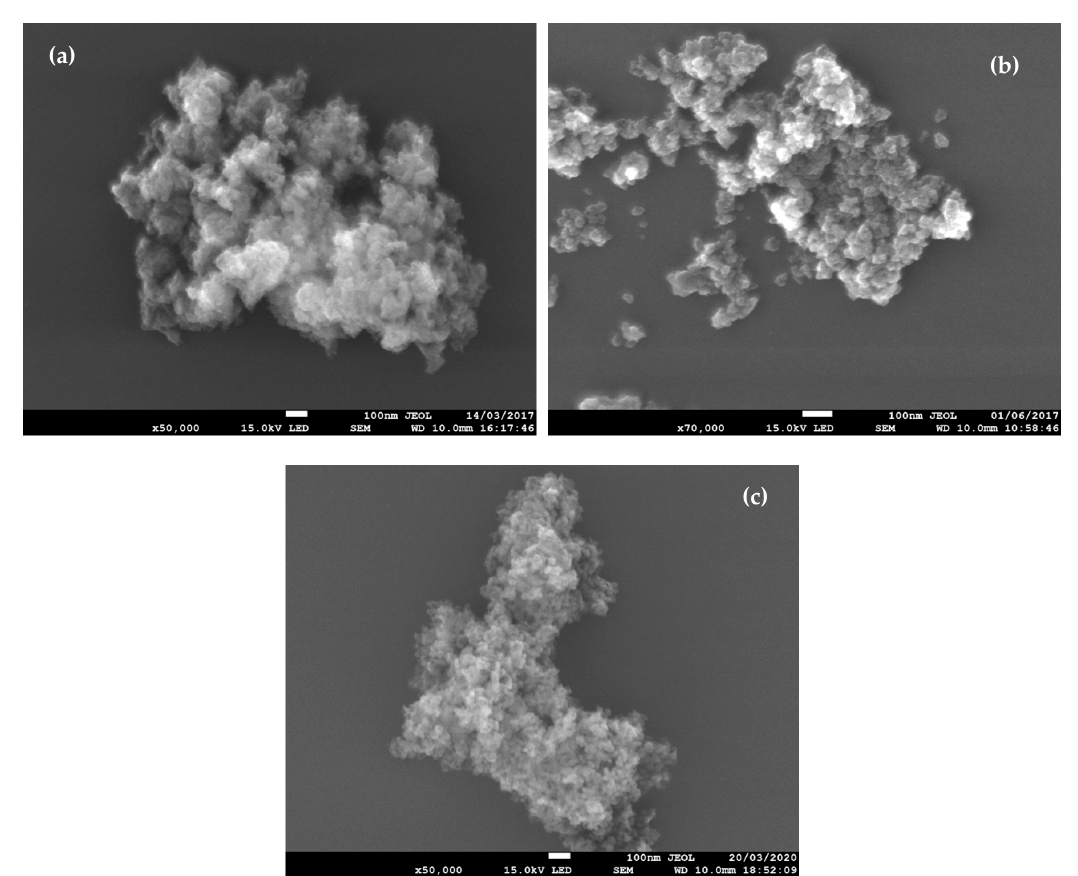
Figure 6. Field Emission Scanning Electron Microscopy (FESEM) images of ( a ) HAp, ( b ) TiO 2 , and ( c ) HT nanocomposite.